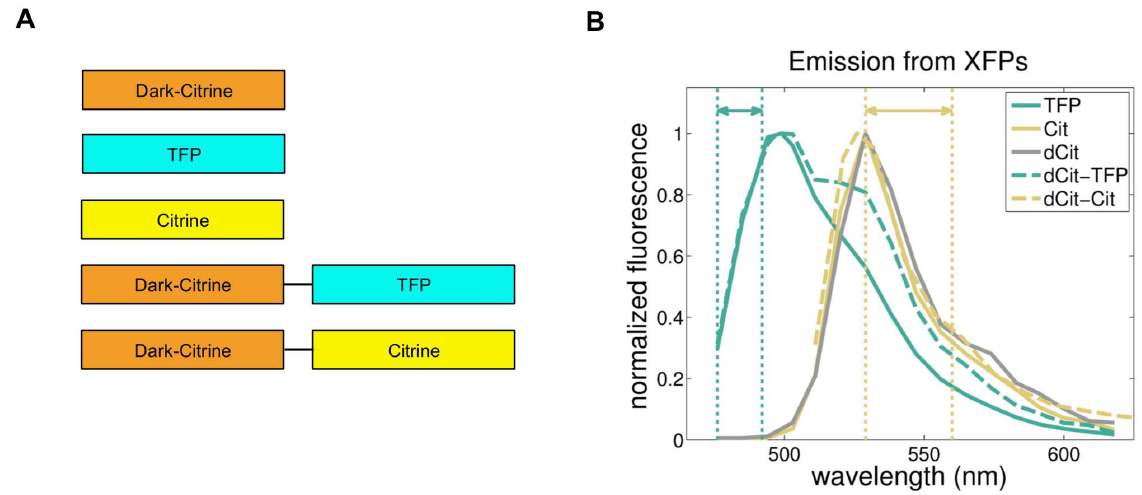
Figure 1. Fluorescent proteins. A) Body plan of fluorescent proteins. DarkCitrine is fused to the N terminus of TFP and Citrine with a GSGG linker (black bar). B) Emission spectra from yeast expressing each XFP excited by a 458 nm laser and emission collected from 460–650 nm. (Double-headed arrows indicate wavelength bands used in Figure 2)